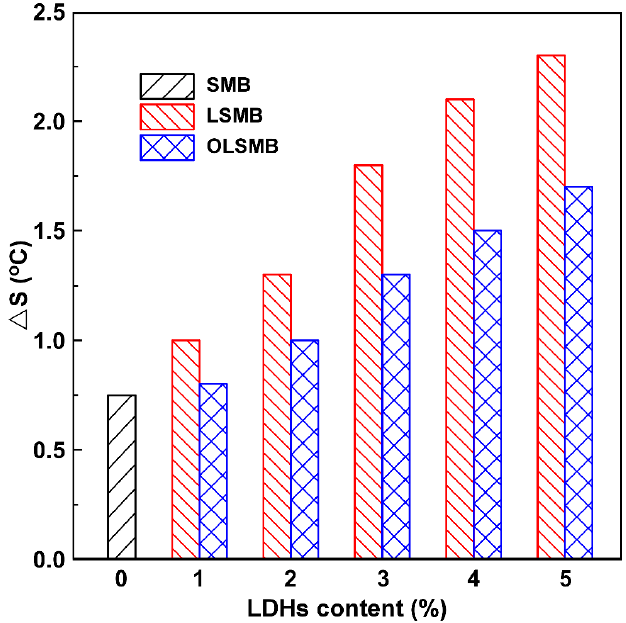
Figure 2. The storage stability of SMB, LSMB and OLSMB.